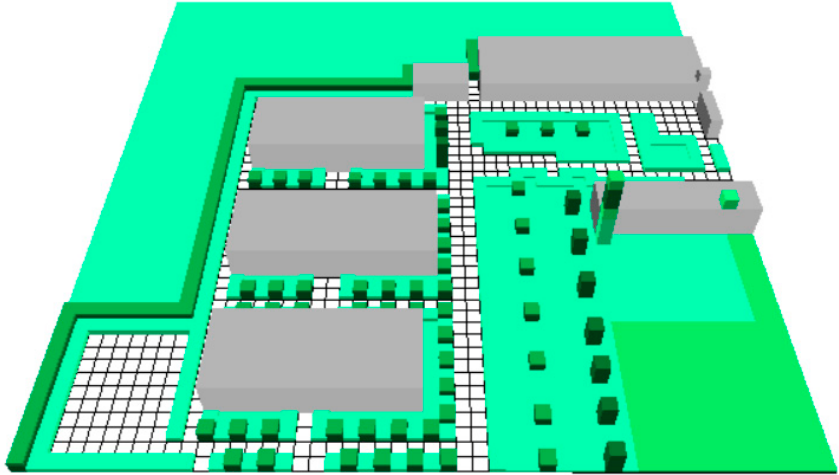
Figure 3. ENVI-met model of the study area.